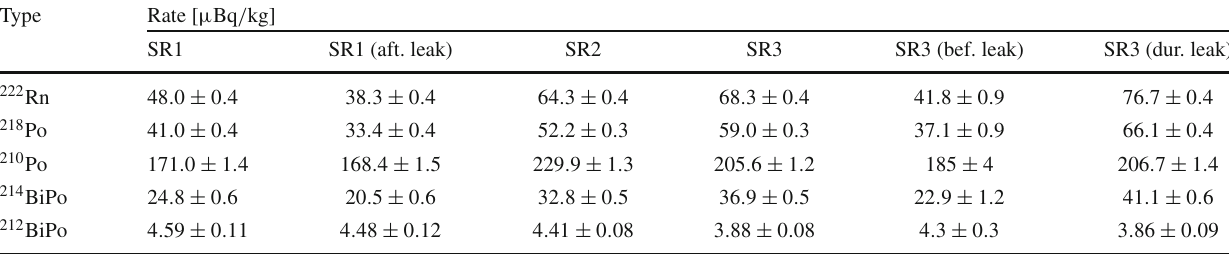
Table 1 Average specific rates for all SRs (statistical errors only). The leak period of SR1 ends on February 7, 2010, and the leak period of SR3 lasts from June 27, 2013, to December 1, 2013. Note that the 210 Po